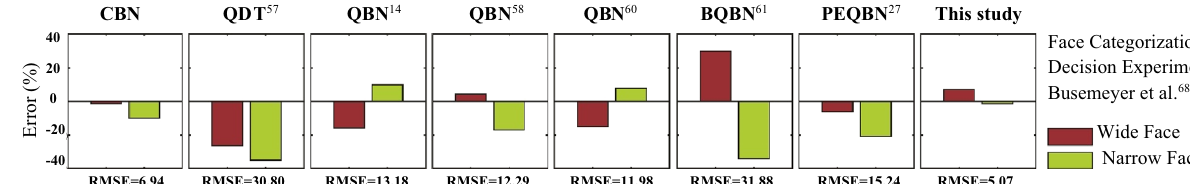
Figure 7. Graphical illustration of errors between empirical results (Table 5) and predicted probability of taking defensive action without categorization. Predicted results are obtained by applying CBN, six quantum-like decision models, and the proposed BEQBN model in this study on Categorization-Decision Experiment 68